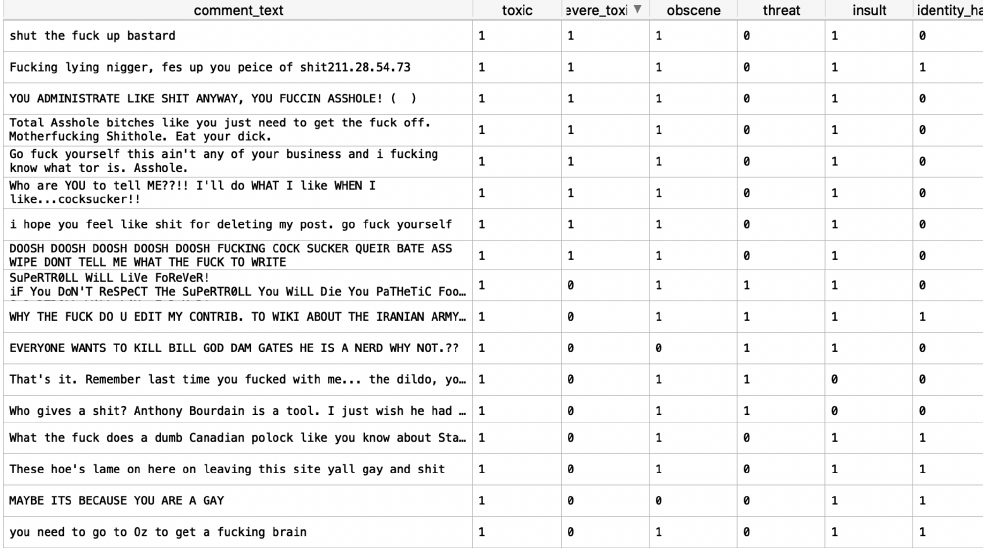
Figure 4. Sample of training data Toxic Comment